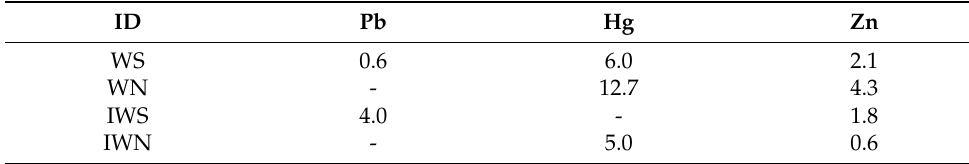
Table 5. Pollution index (P i ) of groundwater and surface water.